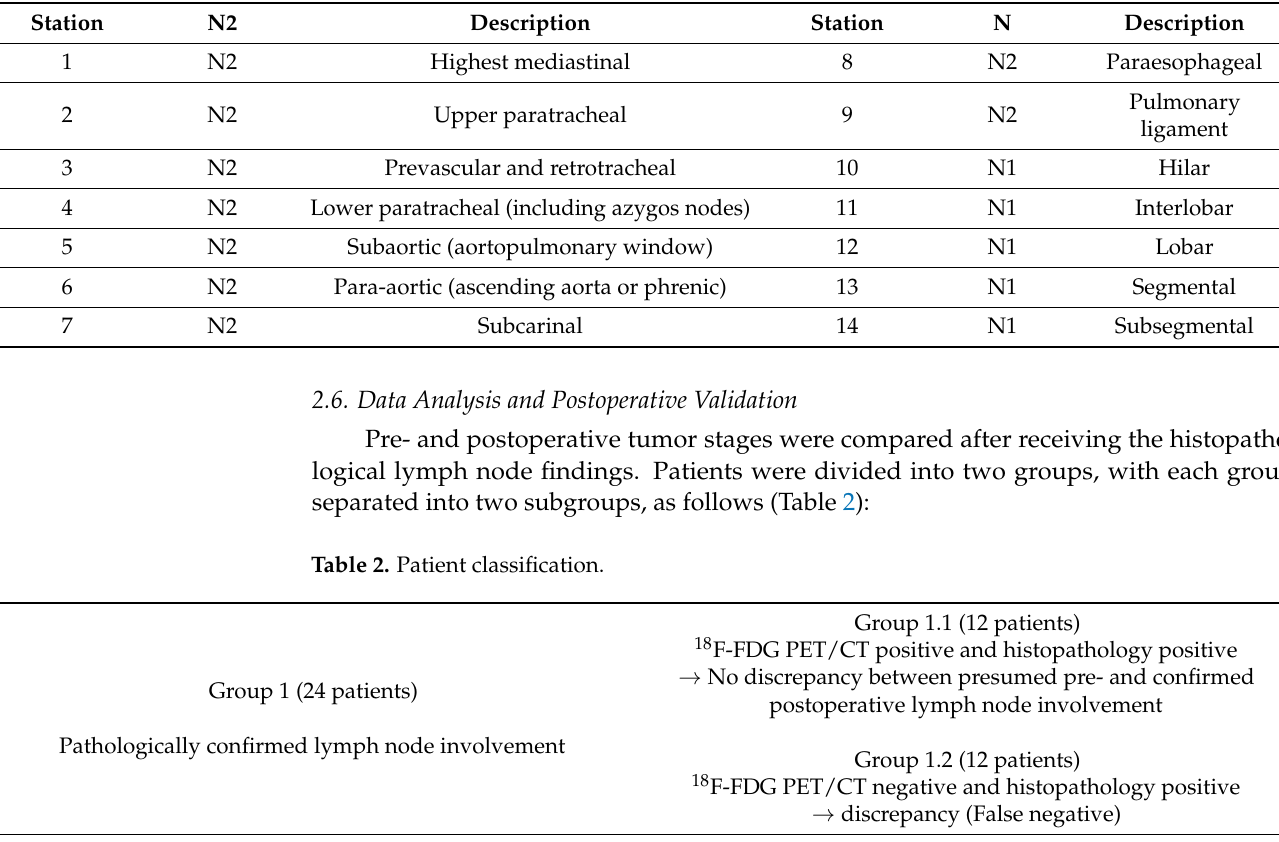
Table 1. Standard histology sheet for localization of mediastinal lymph nodes.